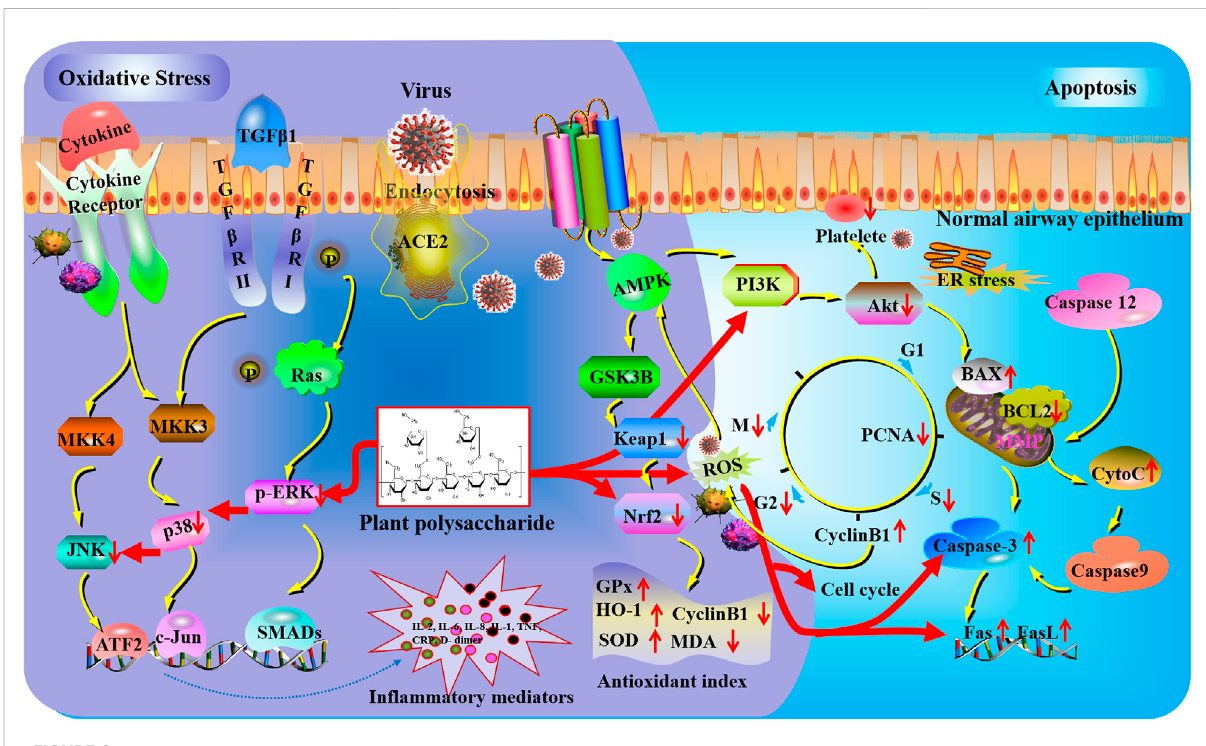
FIGURE 2 Oxidativestressandapoptosismechanismsofplantpolysaccharidesagainstlunginjury.COVID-19induceslungoxidativestressinjury via ACE2 (angiotensin-converting enzyme II) receptor-mediated endocytosis into the airway epithelium. Plant polysaccharides could affect reactive oxygen species (ROS) generation and nuclear factor erythroid 2-related factor 2 (Nrf2) activation to regulate oxidative damage. The expression of c-Jun N-terminal kinases (JNKs), phosphorylated extracellular signal-regulated kinase (p-ERK), and p38 were obviously inhibited by plant polysaccharides.Theactivationofplateletscouldbesuppressedbyplantpolysaccharides via thePI3K/AKTpathway.Plantpolysaccharidescanaffect caspase-3 to regulate the gene expression of fatty acid synthase (Fas) and Fas antigen ligand